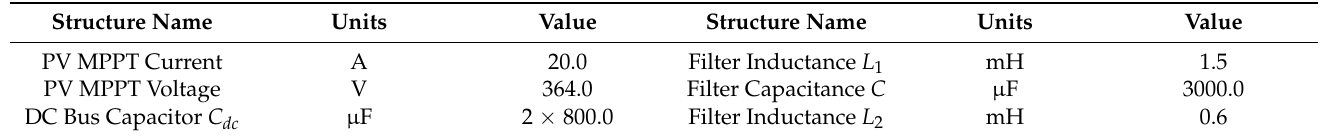
Table 2. Main parameters of improved two-stage system.